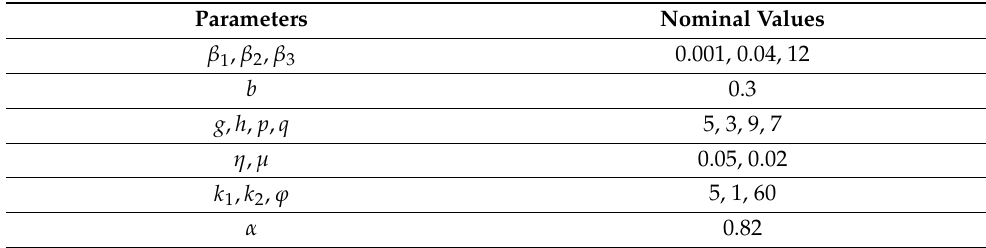
Table 2. System control parameters.